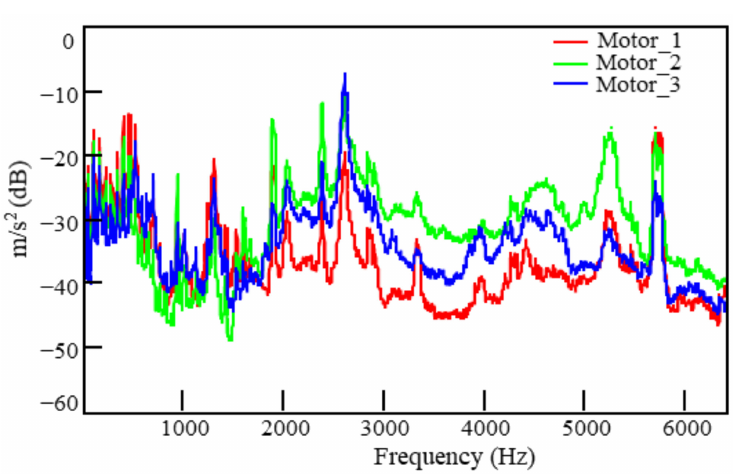
Figure 14. Frequency spectra of excitations at Points 1, 2, and 3 on the motor surface under the 50 km/h working condition.